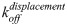
Dissociation kinetics of SAV-BcO and SAV-BFl complexes.(A) Concentration dependence of the displacement reaction of SAV-BcO complex (AB1 model) by unlabeled B7 at 20°C. The concentration of challenging B7 was 740 nM (blue), 1240 nM (pink) and 1740 nM (red) after the remaining free binding sites were filled. The half-times were 56.6 s, 33.9 s and 24.2 s, respectively; with a release amplitude of 79 ± 1%. (B) Temperature dependence of the displacement reaction of SAV-BcO by unlabeled B7 for the AB1 filling model (at 20°C and 27°C) and for the AB4 model (at 20°C). The corresponding koffdisplacement (calculated from the slope) were 1.6 ± 0.4 × 105 M-1s-1, 4.6 ± 0.3 × 105 M-1s-1 and 1.2 ± 0.3 × 105 M-1s-1, respective. (C) Displacement reaction of unlabeled B7 and SAV-BFl complex (AB1 filling model) at 30°C. The concentration of challenging B7 was 1400 nM which produced a release of only 5% of the bound probe. The green curve is the observed data and black curve is the fitted curve for which only 6.5% displacement was observed for SAV-BFl complex in contrast with 79% in case of the complex formed with the longer linker BcO.